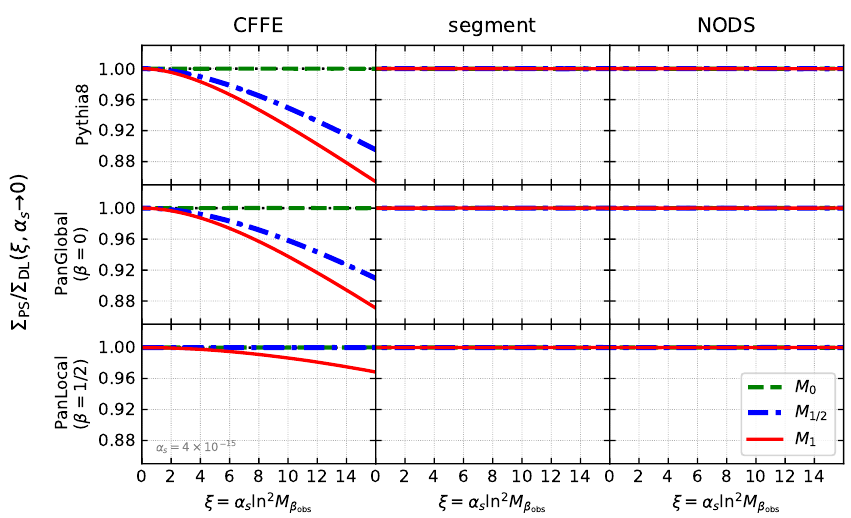
Figure 9. Double-logarithmic tests for event shapes, showing the ratio Σ PS / Σ DL in the limit of α 0 for fixed ξ = α ln 2 M , as a function of ξ . The M observables are defined in s → s β obs β obs eq. (7.8), with M equivalent to the Cambridge y clustering scale, and M similar to the thrust at 0 3 1 DL accuracy. Each row shows a different parton-shower algorithm, each column a different colour scheme, and each subplot shows results for three values of β . Showers that are DL-FC accurate obs give a ratio of 1 for all ξ . The CFFE scheme shows DL discrepancies for at least some of the observables for each shower. The segment and NODS schemes agree with the DL-FC